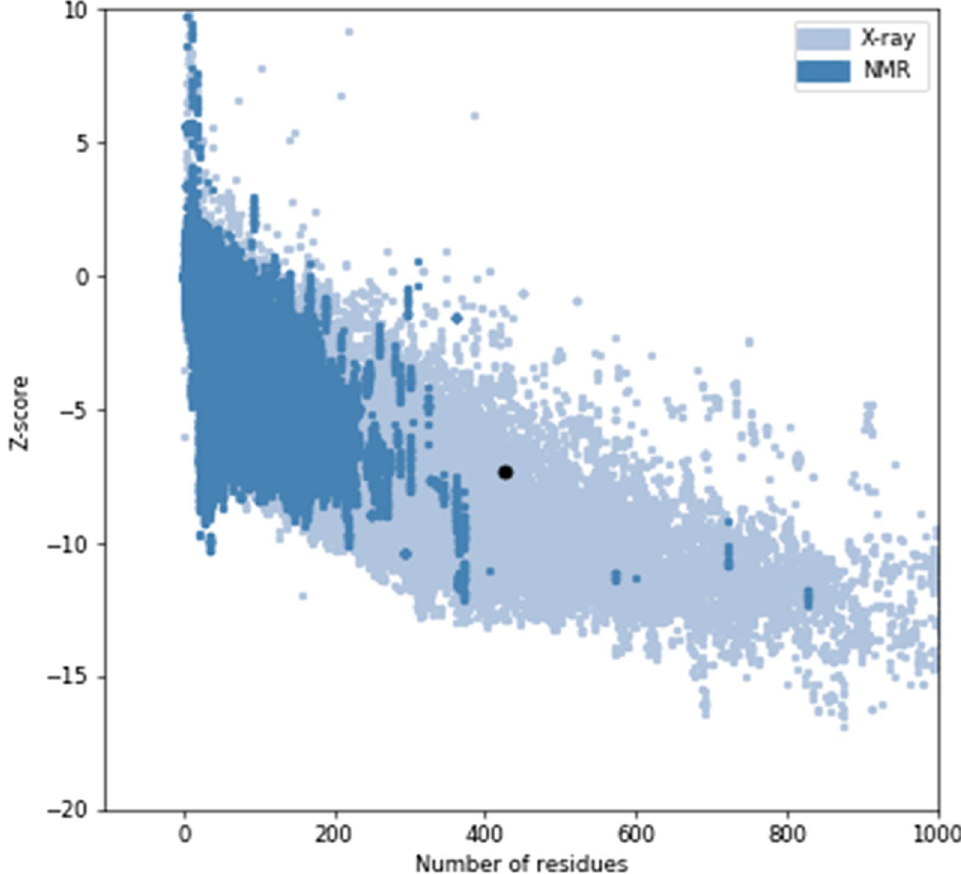
residue length of 426. Figure 7 depicts the Ramachandran plot that was obtained from PROCHECK in which 89.1% of the residues lie in the additionally allowed